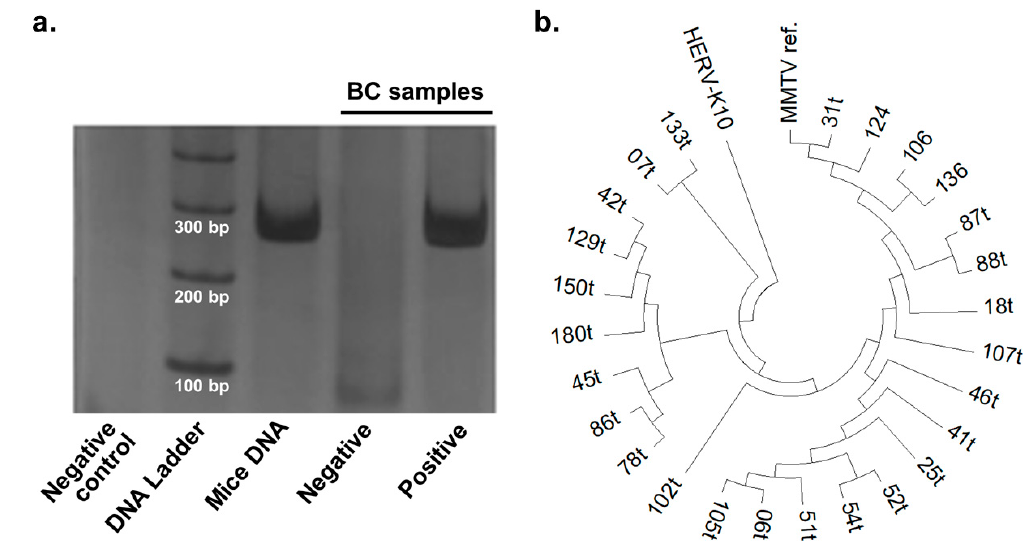
Figure 1. Amplification and sequencing of MMTV-like env sequences. ( a ). Representative picture of polyacrylamide gel after electrophoresis showing a positive and a negative BC sample for MMTV-like env amplification along with negative and positive controls (pooled murine mammary gland DNA). ( b ) . Phylogenetic tree showing that amplicons from BC samples (represented by numbers) vary in nucleotide sequence and are homologous to MMTV env reference sequence (MMTV ref.) but not to HERK-10 reference